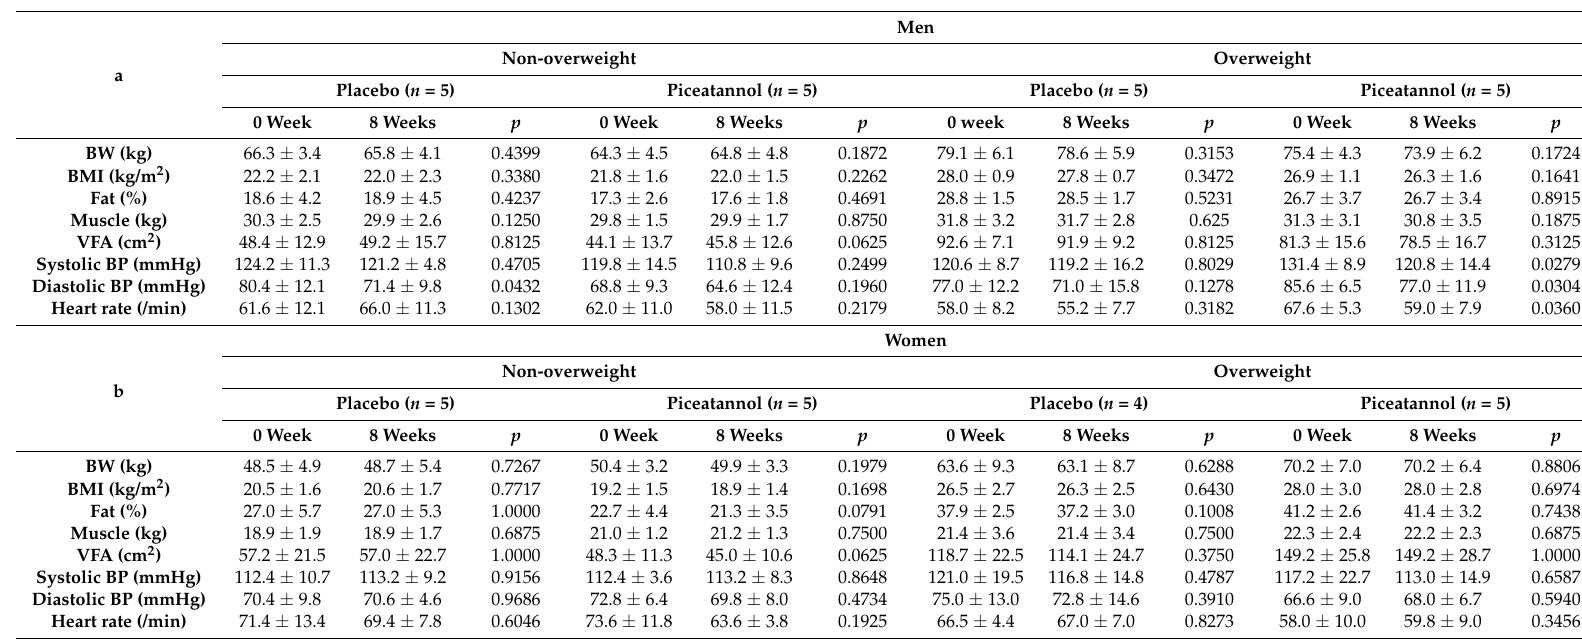
Table 2. Body weight, body mass index, and body composition including % fat, muscle weight and visceral fat area, blood pressure and heart rate at baseline and after 8 weeks of placebo or piceatannol supplementation (a: men, b: